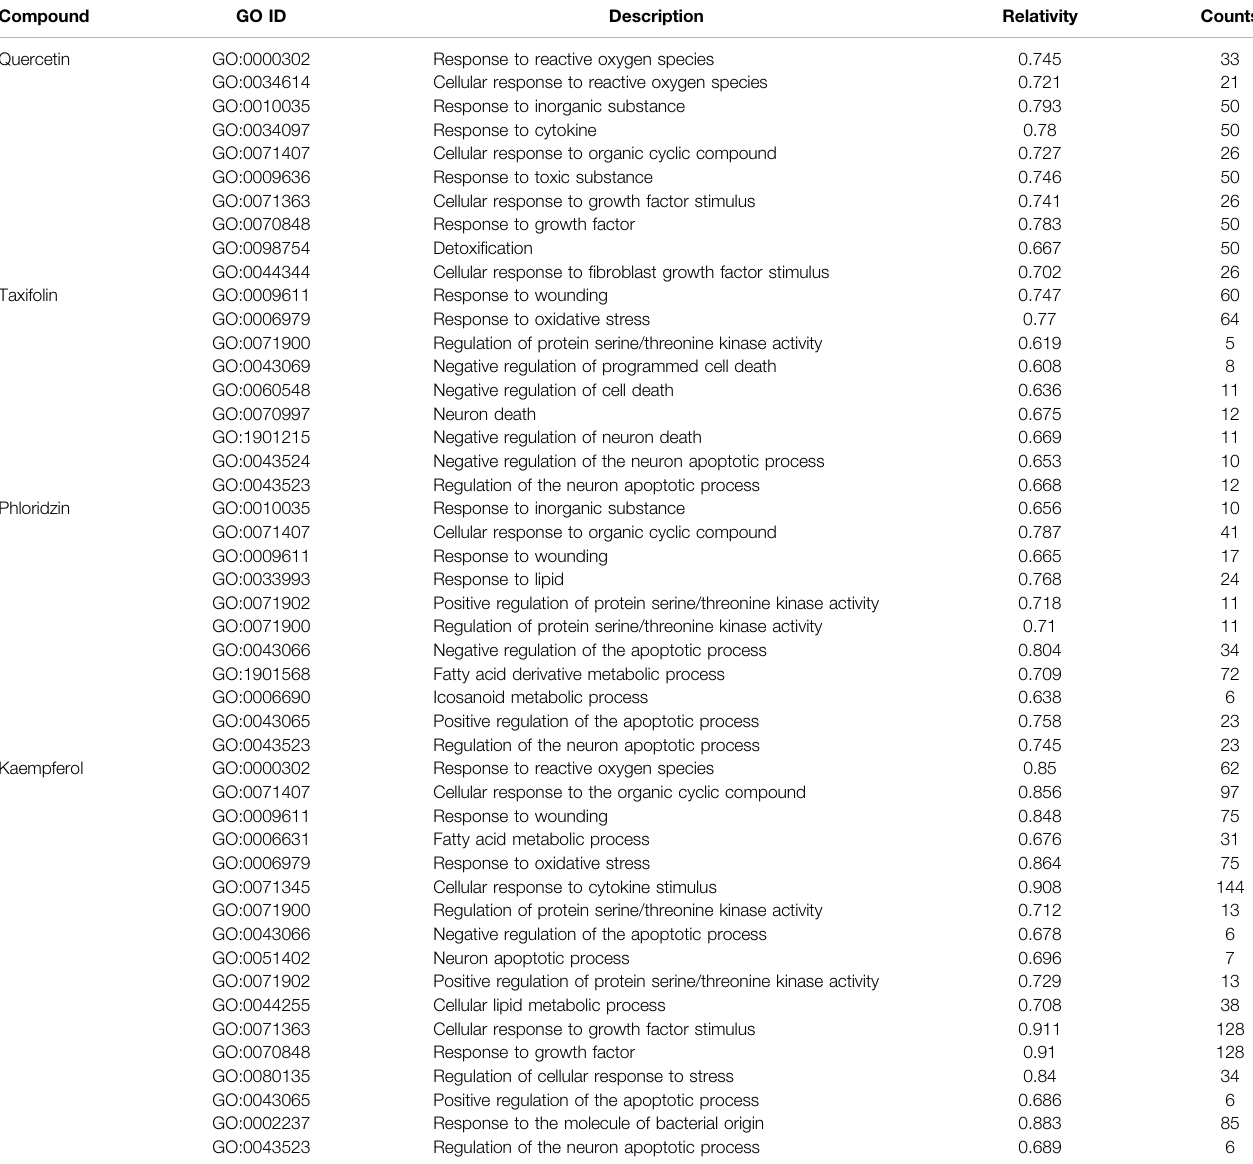
TABLE 5 | Gene set correlation and hit count of GO similar functional modules.